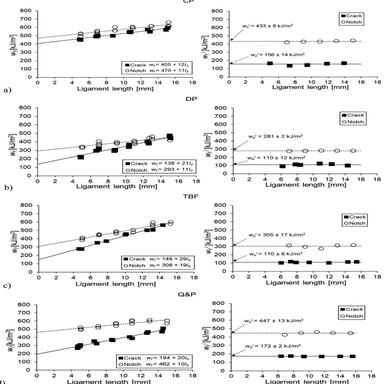
EWF results for the investigated AHSS grades: (a) CP, (b) DP, (c) TBF and (d) Q&P. Solid symbols correspond to the EWF values obtained with fatigue pre-cracked specimens, open symbols correspond to notched specimens. Left: wf values as a function of the ligament length. Right: wf i values as a function of the ligament length. The average cracking initiation value (we i ) is indicated.